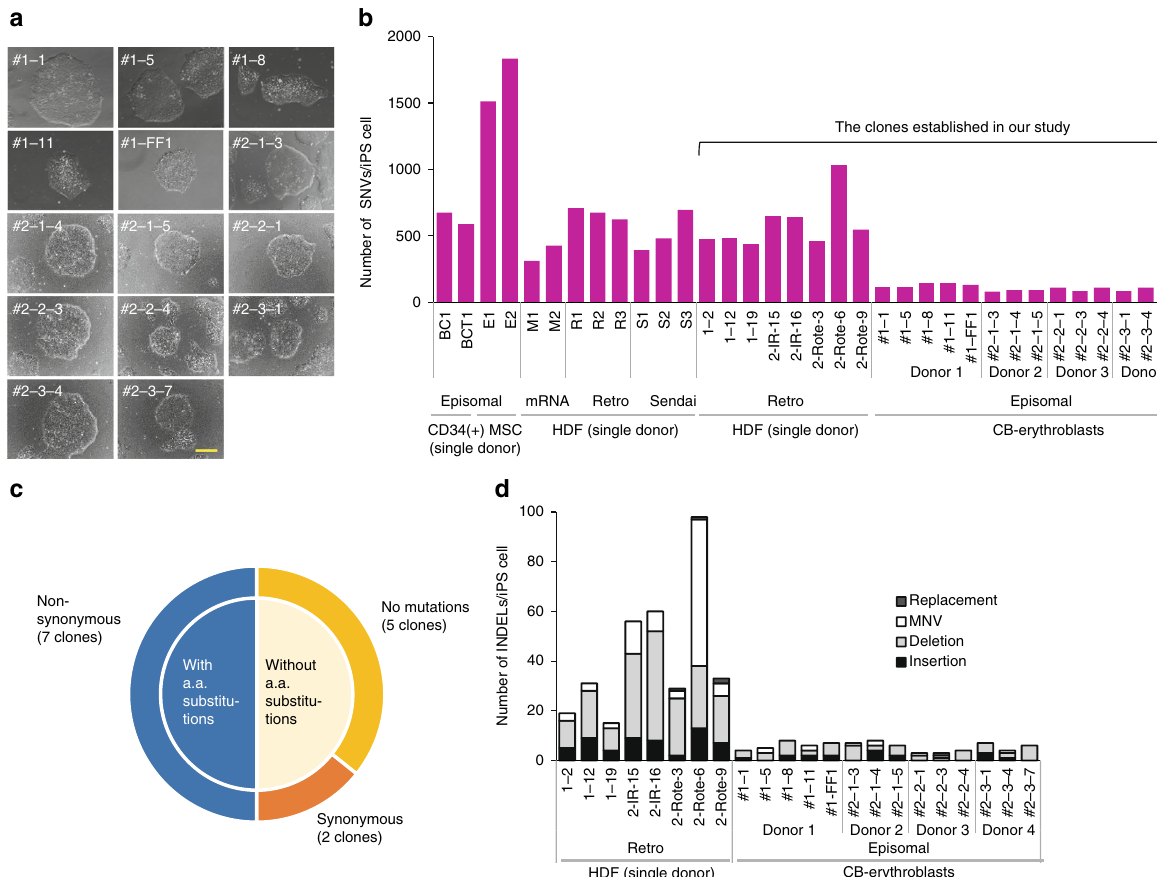
Fig. 1 Generation of human iPSCs harboring fewer point mutations. a Morphology of the established human iPSCs generated from the erythroblast-rich fraction expanded from cord blood. The asterisk denotes ‘ CB-epi- ’ (e.g. #1 – 1 indicates clone CB-epi-1-1). Scale bar, 300 μ m. b The number of SNVs observed in various human iPSC clones. Twenty-two lines were established in this study including 14 genome integration-free human iPSC lines derived from four different donors and eight lines generated by retroviral gene transduction from human dermal fi broblasts (HDF). In addition to our human iPSC clones, we re-analyzed the WGS data for 12 previously reported human iPSC clones: BC1, BCT1, E1, and E2 2,75 and M1, M2, R1, R2, R3, S1, S2, and S3 5 .